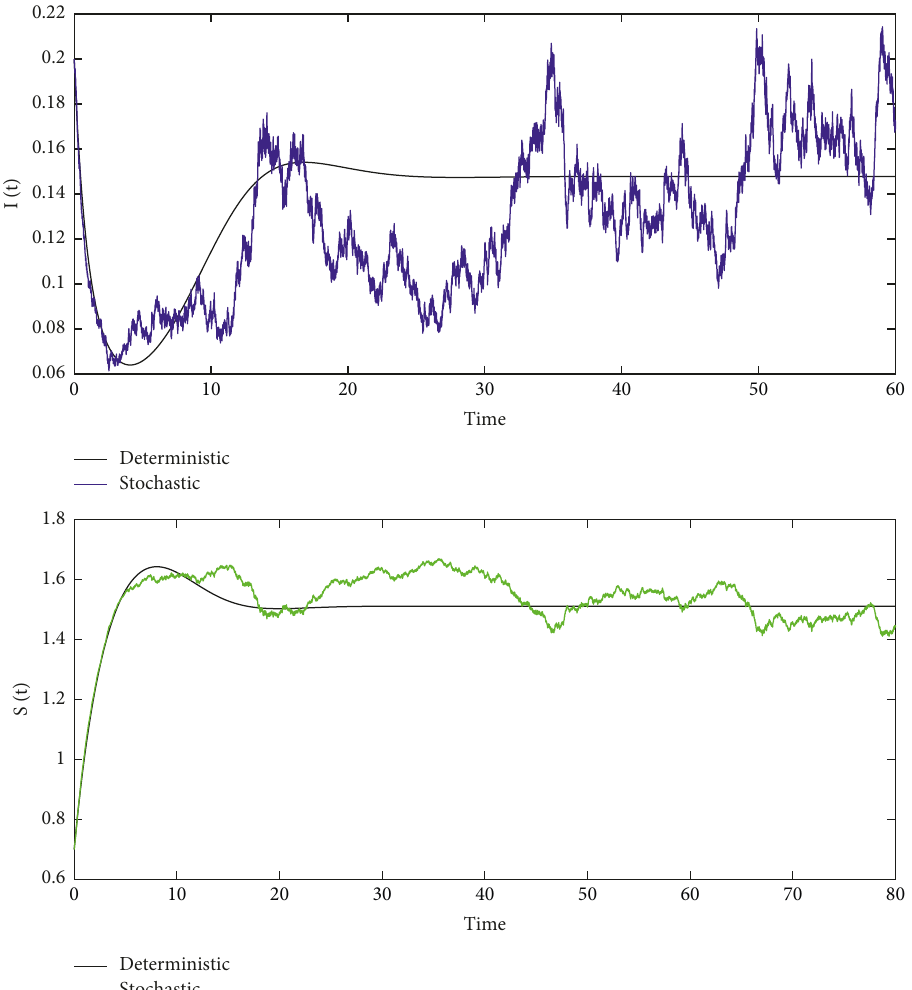
Figure 2: Comparison of the trajectory in stochastic system (3) ( I ( t ) : blue graph and S ( t ) : green graph) and deterministic system (1) ( I ( t ) : black graph and S ( t ) : black graph) for the persistence